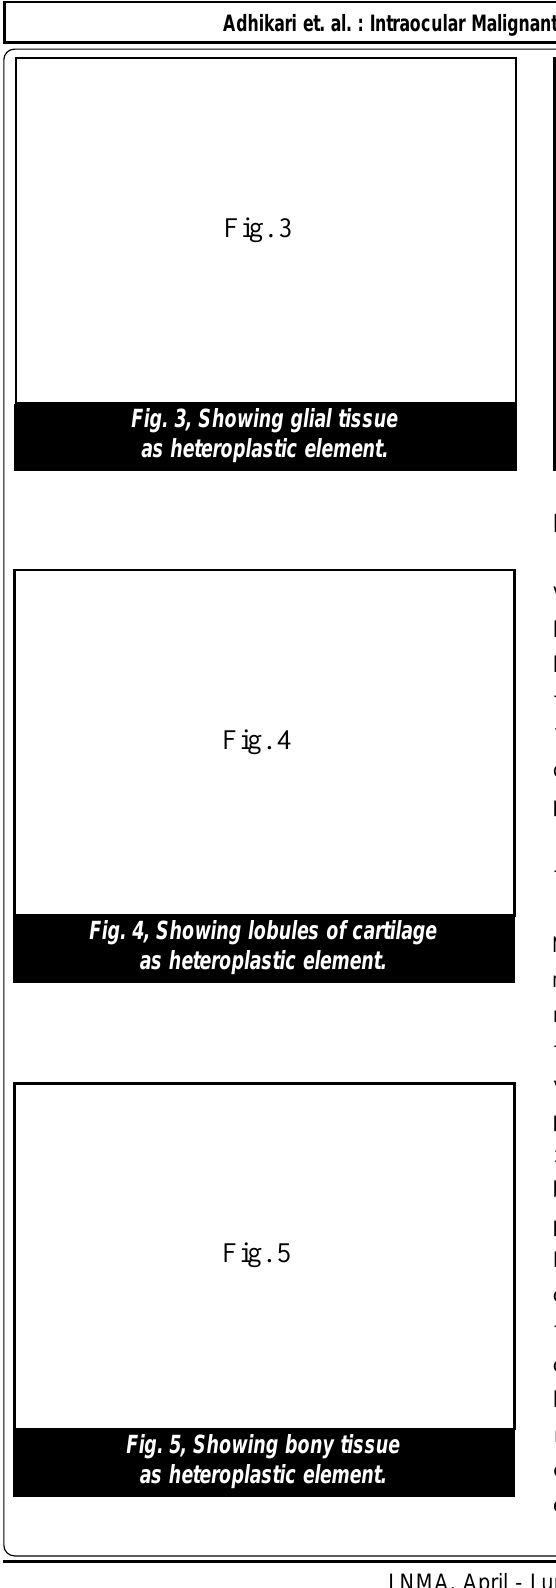
as heteroplastic element.